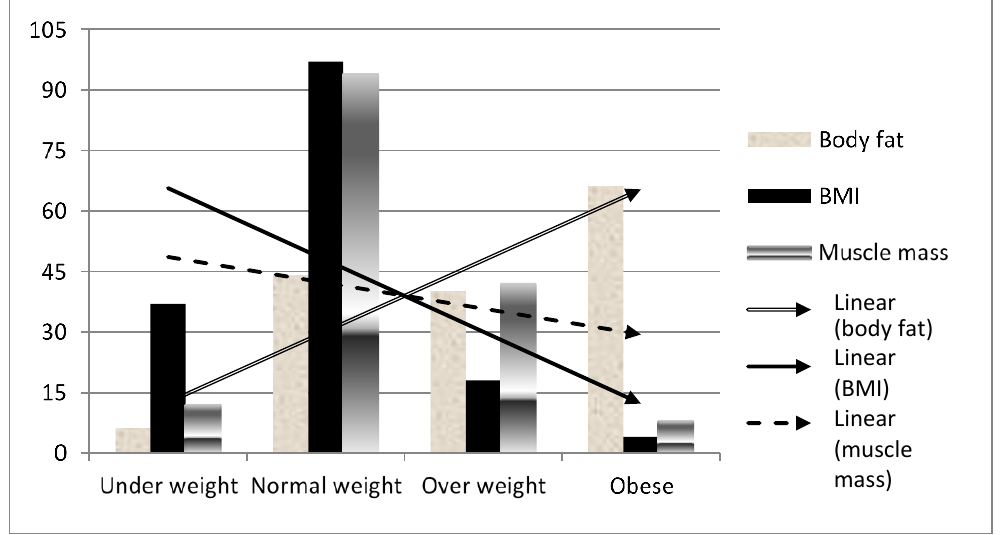
Fig. 1 Data distribution and trend lines for 3